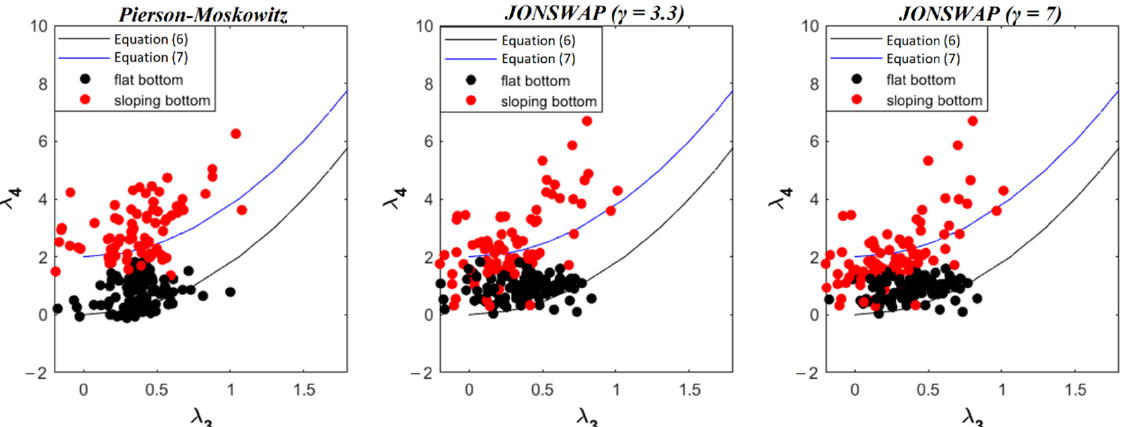
Figure 8. Relationship between skewness and kurtosis from intermediate to shallow water regions before and after the toe of the slope. The solid black line represents the second-order nonlinear theory with respect to water depth change [40]. The solid blue line depicts an adjusted formula introduced by the data found in the sloping bottom.